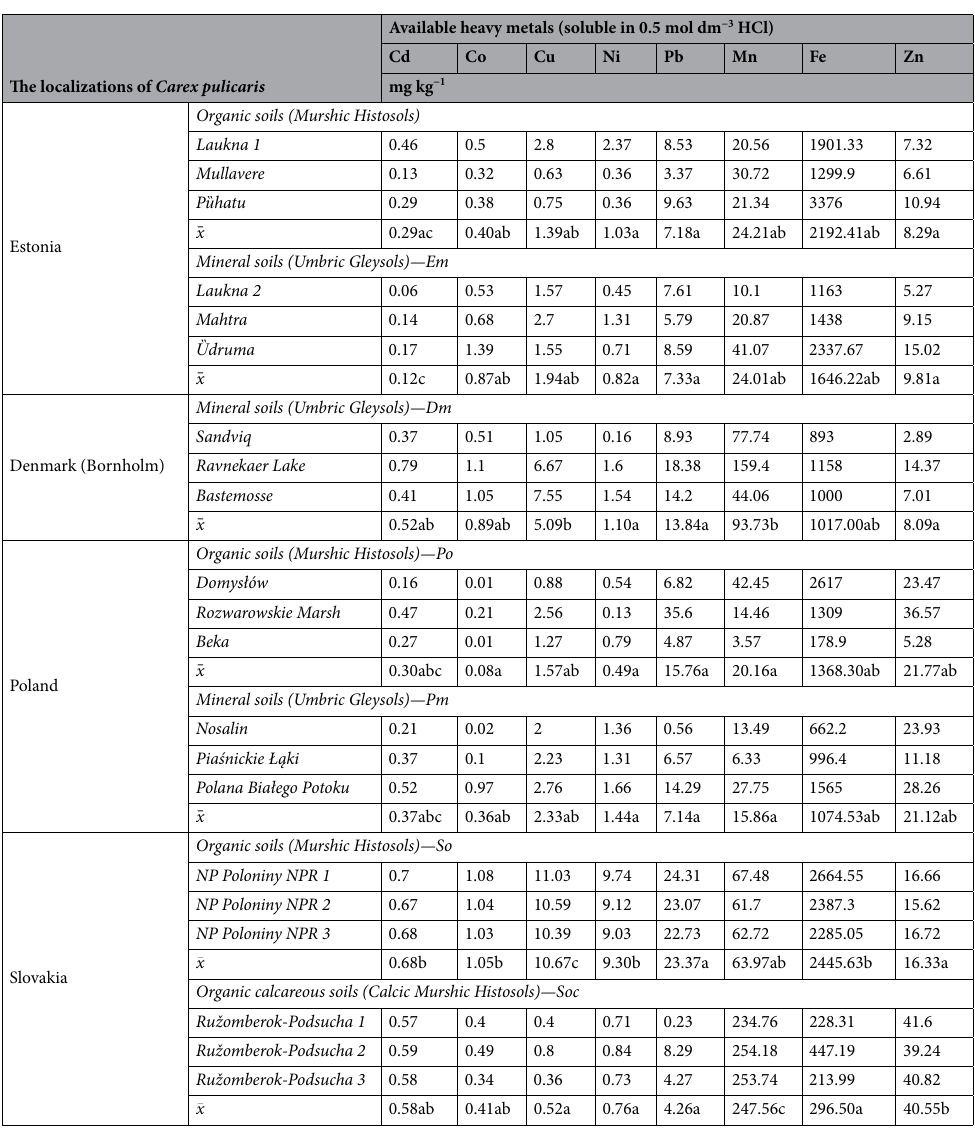
Table 3. Content of available heavy metals in